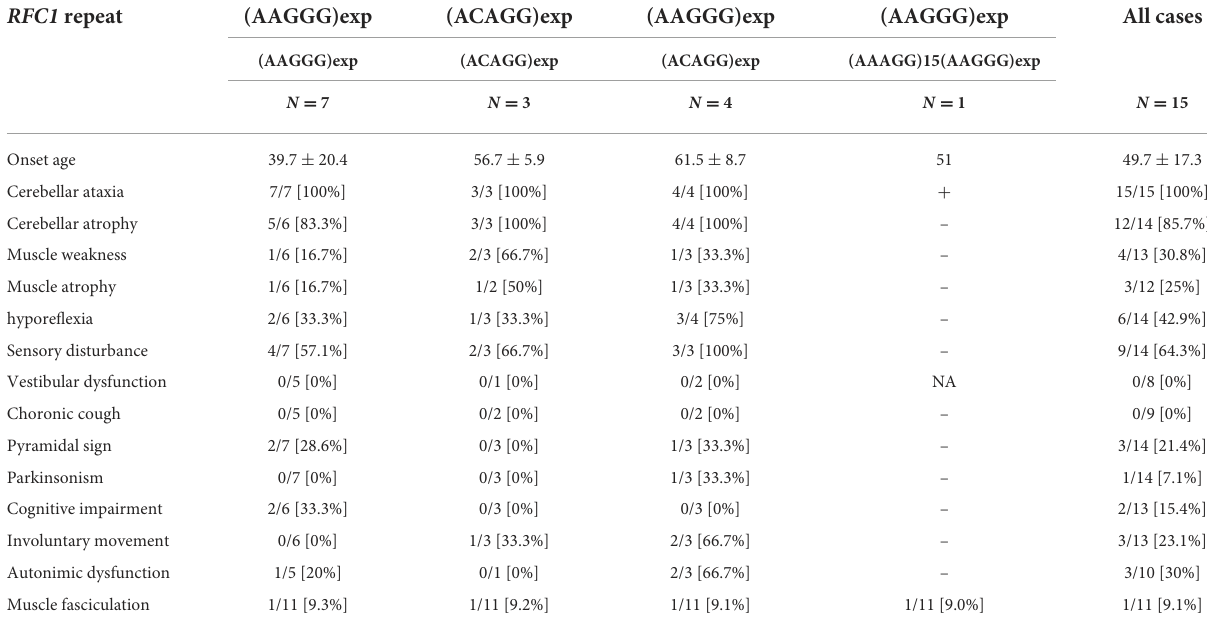
TABLE 3 The proportion of clinical manifestations in each